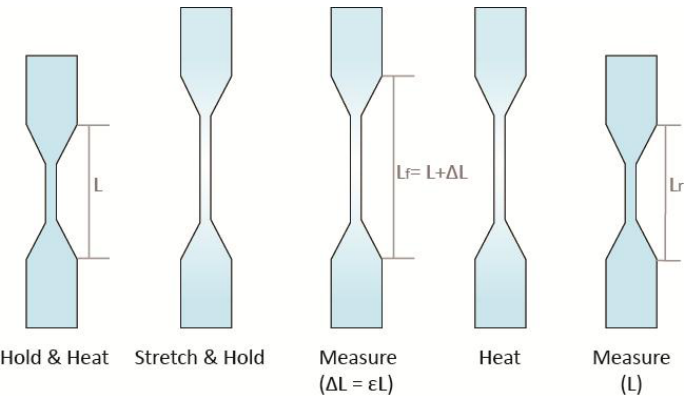
Figure 3. Shape recovery property measurements.